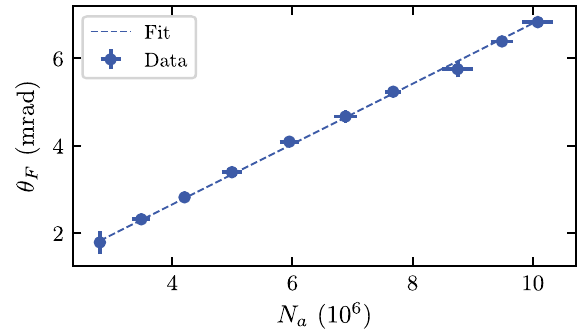
FIG. 6. dc Faraday rotation signal of the atomic ensemble spin polarized along the optical propagation axis at a probe laser detuning of − 2 π × 40 GHz. In the experiment, first the Faraday rotation angle θ was measured with a weak, far-detuned probe F pulse and then the number of atoms N was determined by a absorption imaging. Each data point with error bar corresponds to the mean and the standard deviation of five experimental runs at the same magneto-optical trap loading time. F component of an arbitrary spin state. If the collective z spin is aligned along a magnetic field perpendicular to the propagation direction of the light field, the F component z oscillates at the Larmor frequency. In this case of an oscillating signal, the polarization homodyne measurement of the outgoing field is demodulated by a lock-in amplifier which returns the root mean square (rms) amplitude ¯ ∝ ¯ S V 50 Ω S (where is the slowly varying amplitude y y S y ; rms of S ). In order to determine the Faraday angle from this y ∝ h S i using rms amplitude and the dc measurement of V S x x an oscilloscope, one has to first multiply the rms amplitude ffiffiffi p 2 by a factor to get a peak amplitude voltage and further by a factor of 2 to compensate for the impedance mismatch between the 50 Ω input impedance of the lock-in amplifier and the high input impedance of the oscilloscope. Including these factors, we get the slowly varying amplitude of the